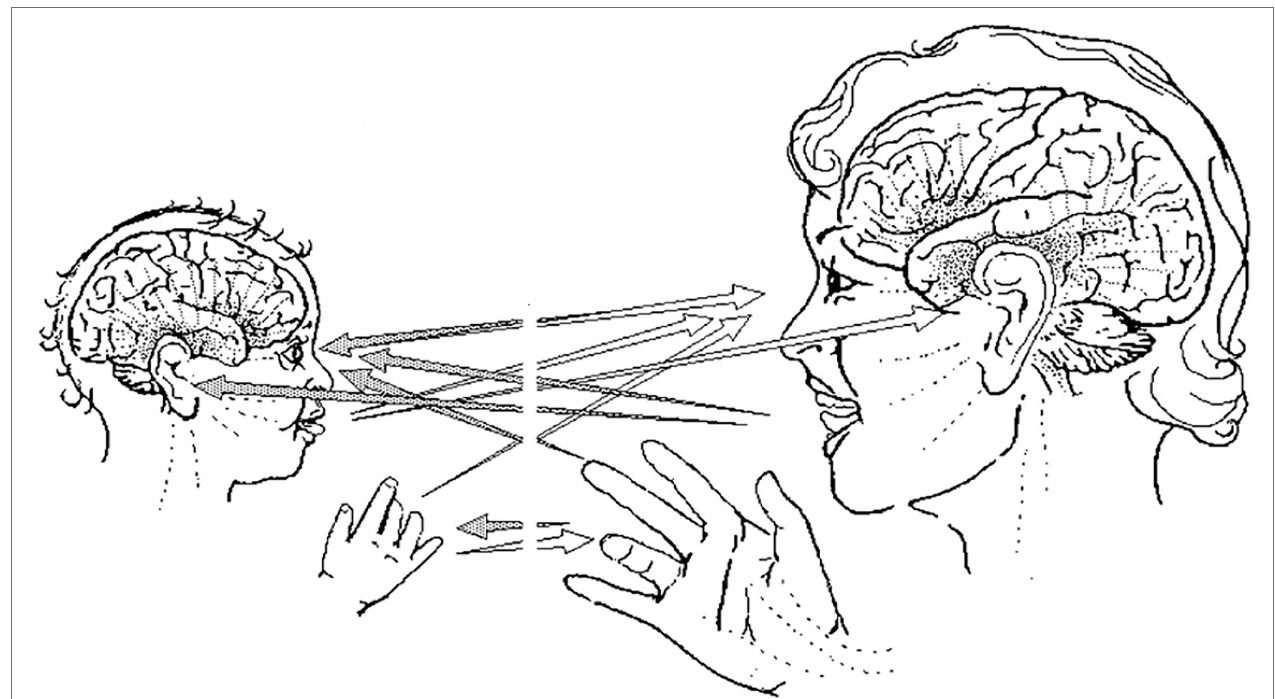
FIGURE 1 | Illustration of multiple channels of protoconversation between an infant and her mother (Trevarthen et al., 2006, Figure